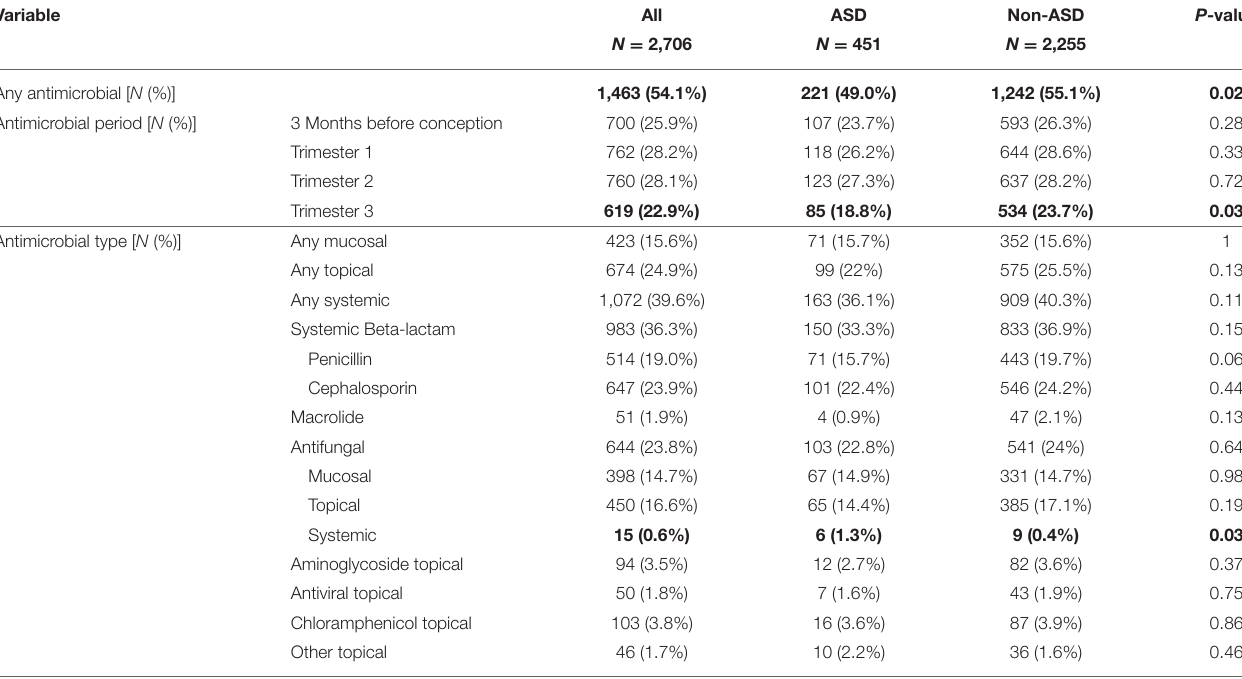
TABLE 2 | Antimicrobials taken by mothers of children with ASDs and matched non-ASDs controls * .